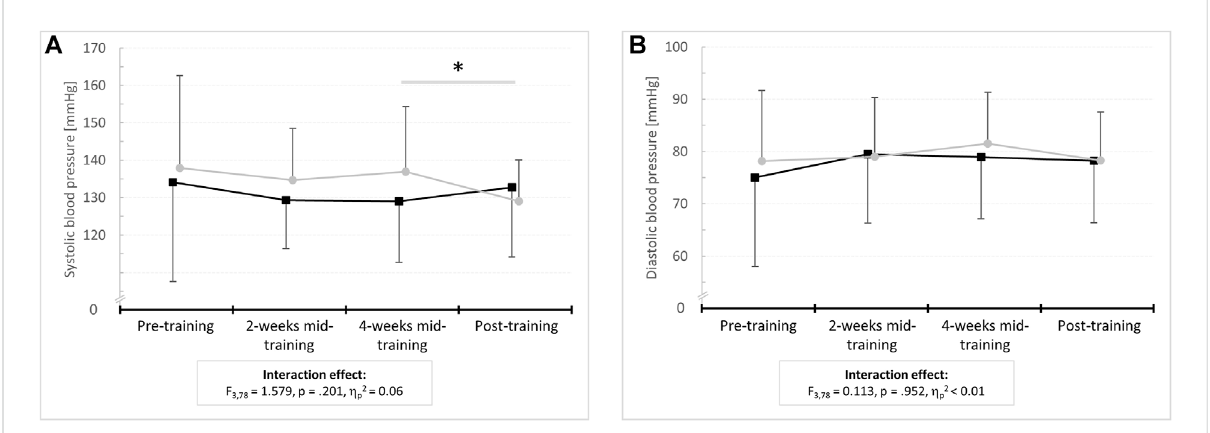
FIGURE 3 Means and standard deviations for resting (A) systolic and (B) diastolic blood pressure before (pre-training) as well as after 2 weeks (2-weeks mid-training), 4 weeks (4-weeks mid-training), and 6 weeks of training (post-training) for the intervention group (IG) and sham control group